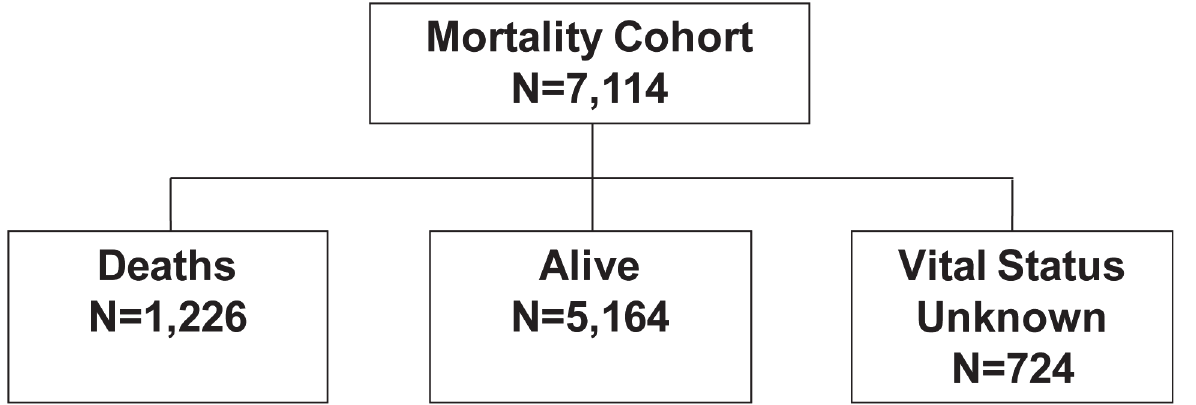
between 200 and 349 cells; 331 (6.9%) initiated at a count > 350 cells/uL. There were 66,007 fol- low-up visits after initiating ART. At 75.2% of these visits, the HIV RNA level was < 400 copies/ mL. The median CD4+ count at study entry for participants who did not initiate ART during follow-up was 335 cells (IQR: 153 to 508). During follow-up, the number of CD4+ counts for each participant ranged from 1 to 36 with a median number of 11 (IQR: 4 – 19). These follow-up statistics were similar for the 5,976 participants in the morbidity and mor- tality cohort. ART was prescribed for 4,999 (83.7%) of these participants at entry or during